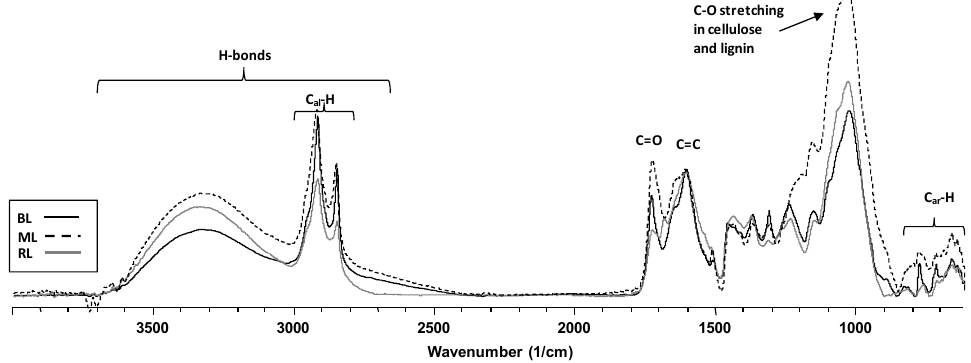
Figure 1. ATR spectra of examined leaves.